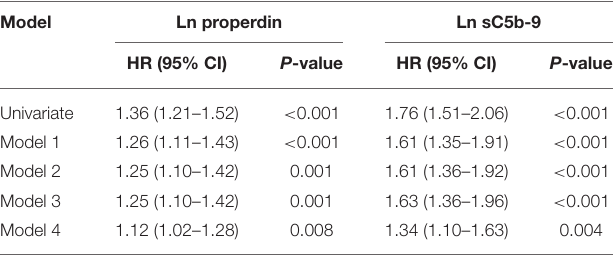
TABLE 3 | Association of continuous natural log transformed urinary properdin and urinary sC5b-9 with graft failure in renal transplant recipients. Model